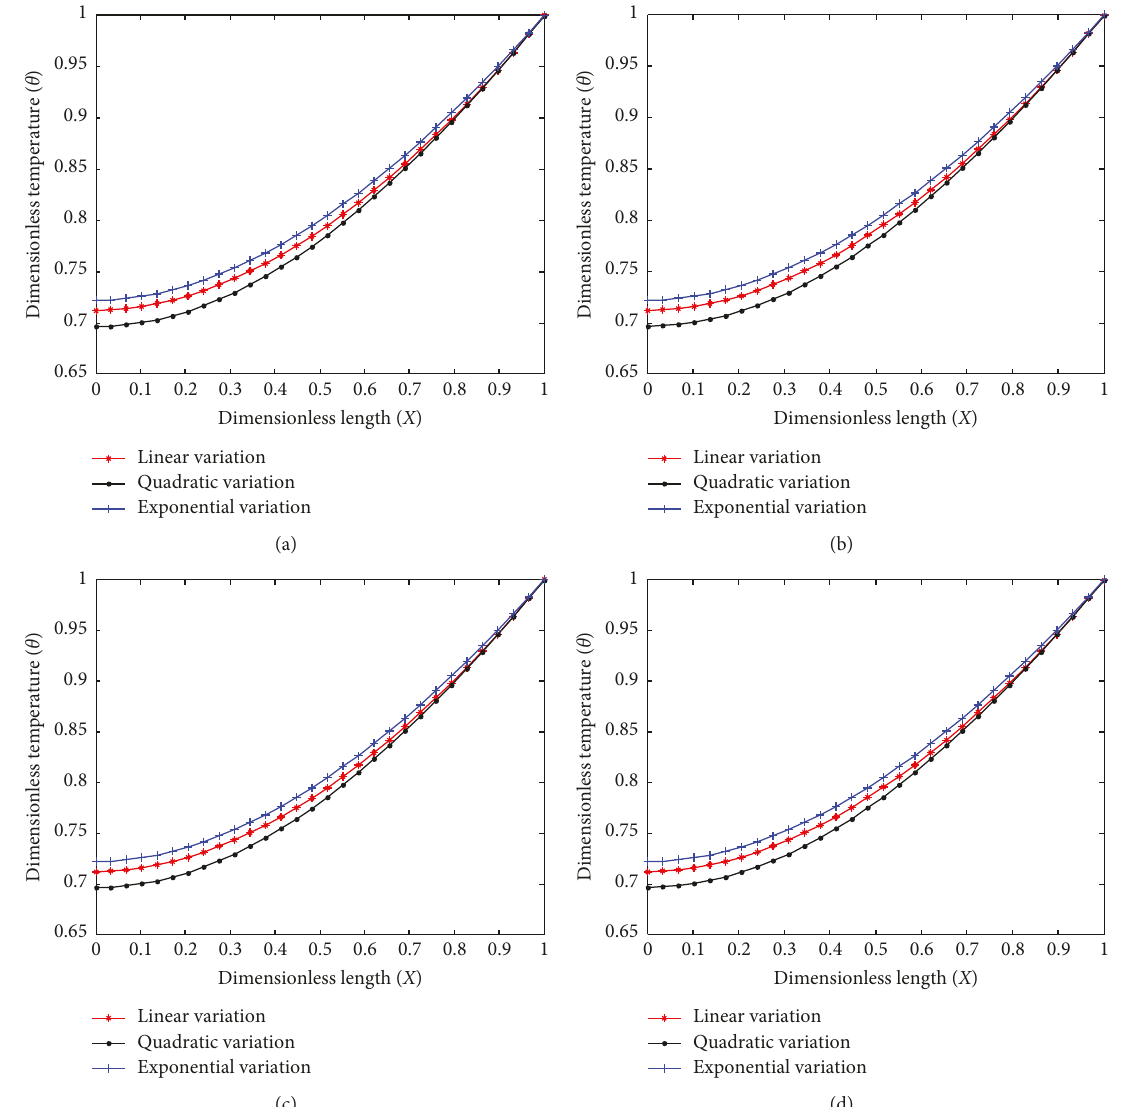
Figure 5: Temperature distribution in the fin for different variable thermal conductivity at (a) τ � 0.1, (b) τ � 0.15, (c) τ � 0.30, and (d) τ � 0.35.